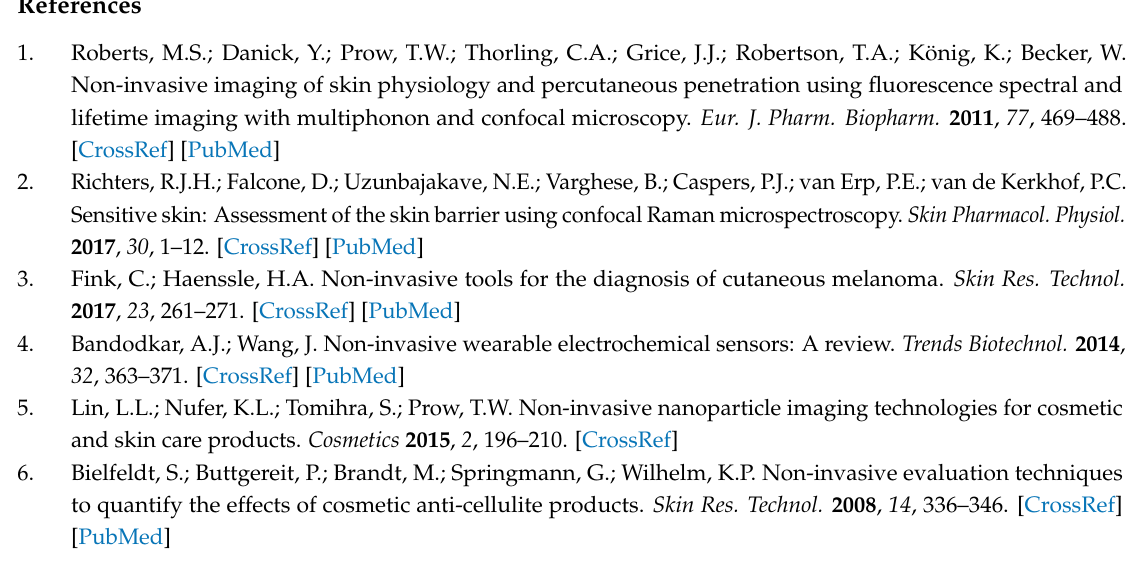
Figure S1: Distribution of compound classes in human skin volatile samples, Figure S2: Distribution of compound classes in volatile samples from human skin